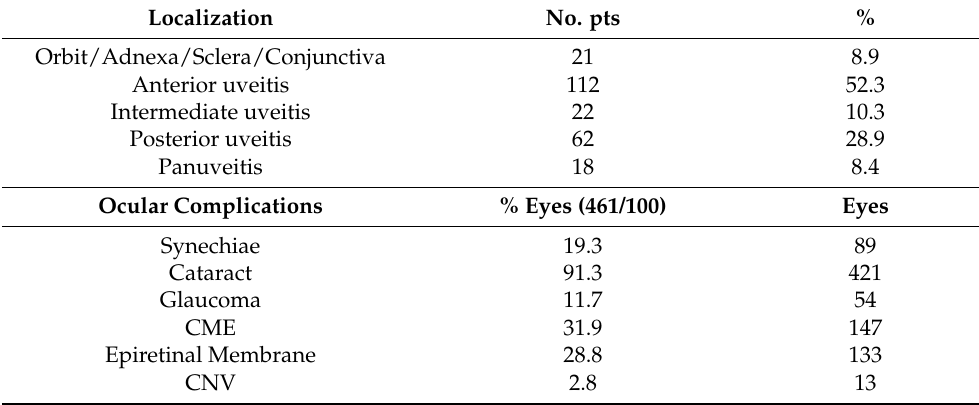
Table 8. Localization of the ocular disease at onset and ocular